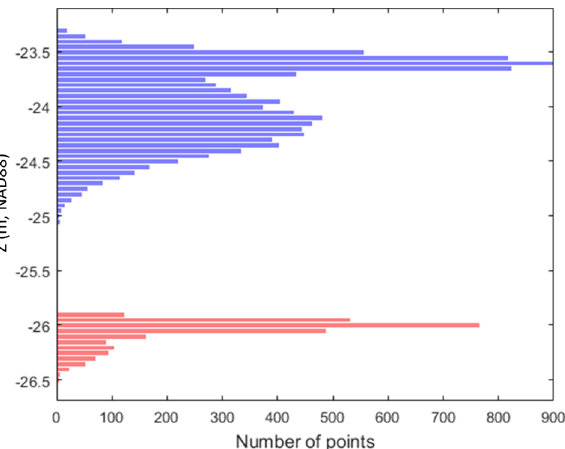
Figure 4. Histogram divided into upper and lower segments. The lower segment is determined to be the seafloor.